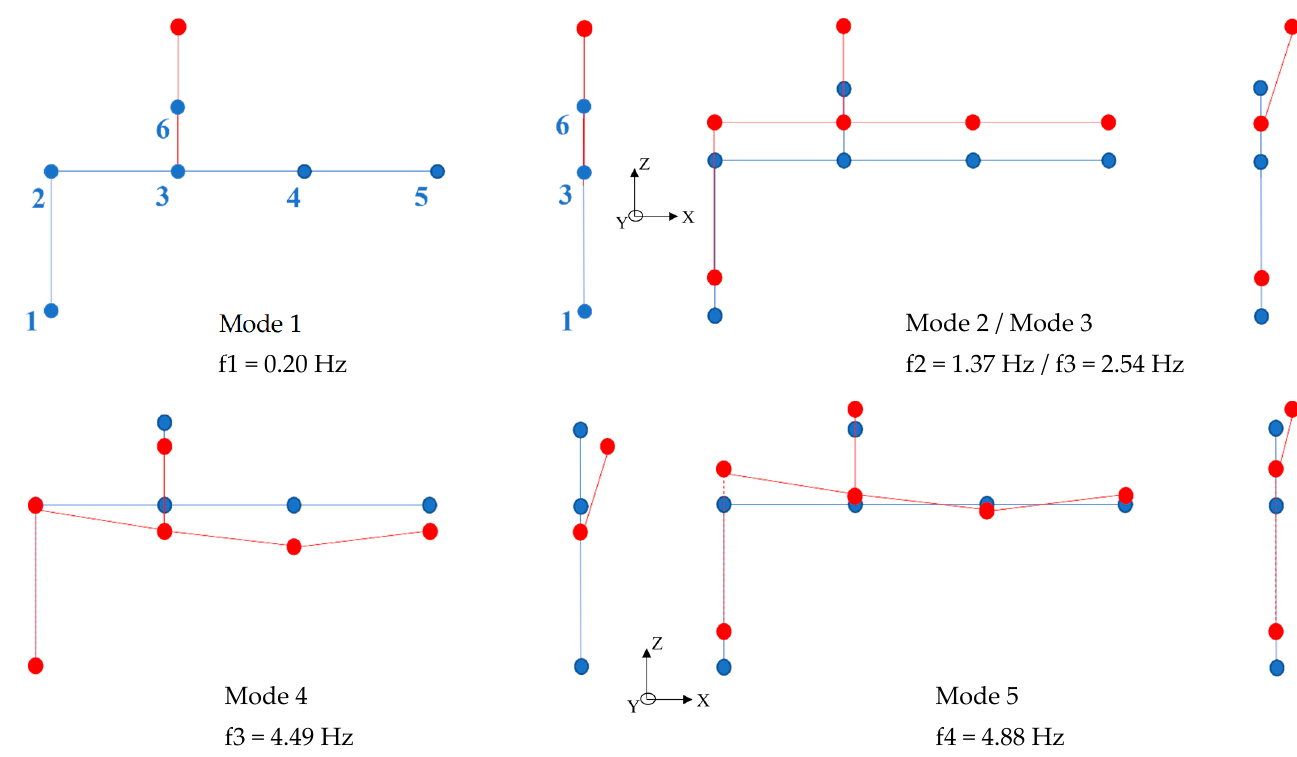
Figure 9. Experimental modal parameters for the comfort seat.